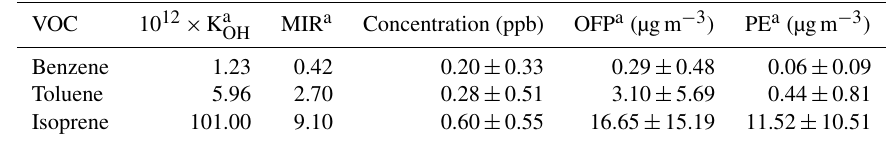
Table 7. Averaged concentrations and photochemical properties of benzene, toluene and isoprene ( ± standard deviation) from the TROICA- 12 campaign.